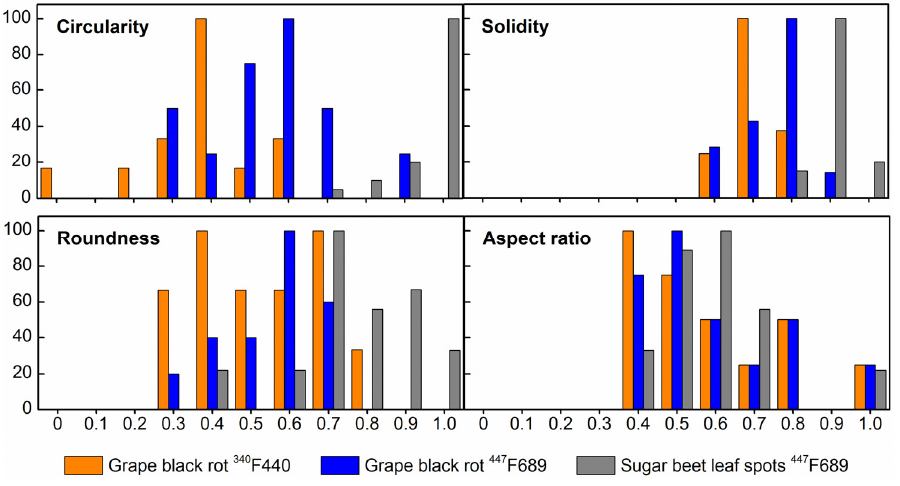
Figure 3. Histograms of four shape parameters analyzed from the fungal symptoms, the data basis was the individual ROIs (fungal symptoms) shown in Figure 1C (sugar beet leaf spots) and Figure 2A, B (grape black rot). Four shape descriptors (circularity, solidity, roundness, aspect ratio) were calculated and the frequency distribution was displayed graphically as histograms. The orange and blue bars are representing the results of the grape black rot symptoms, based on the UV-A-excited blue ( 340 F440) and the blue-excited red fluorescence ( 447 F689), respectively. The analysis of the symptoms of sugar beet leaf spots ( 447 F689) is displayed as grey bars in the